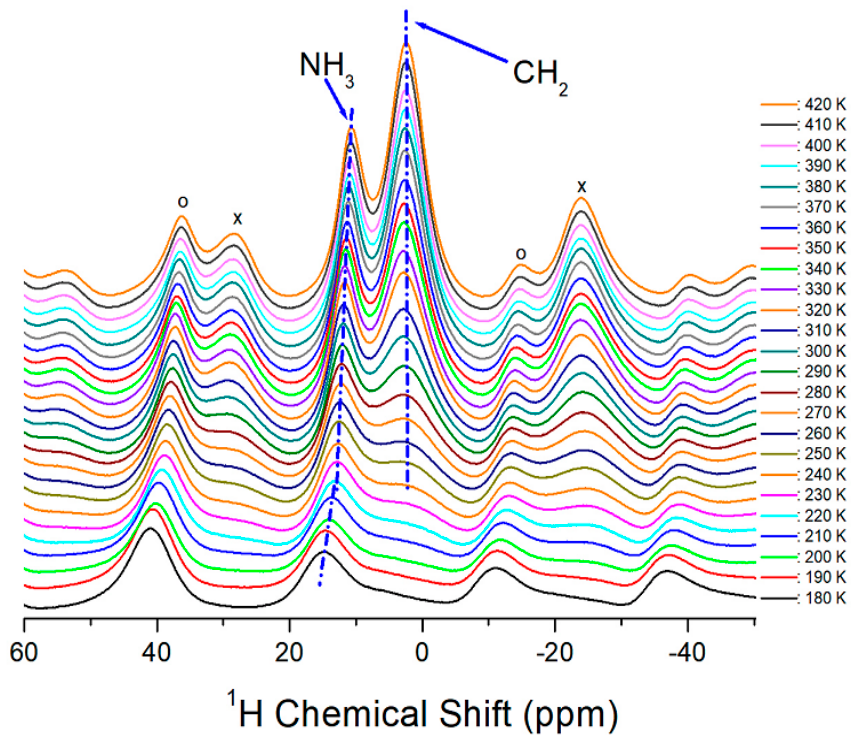
Figure 4. MAS 1 H NMR spectra of [NH 3 (CH 2 ) 5 NH 3 ]CuCl 4 as a function of temperature. Spinning sidebands are indicated by crosses and open circles.